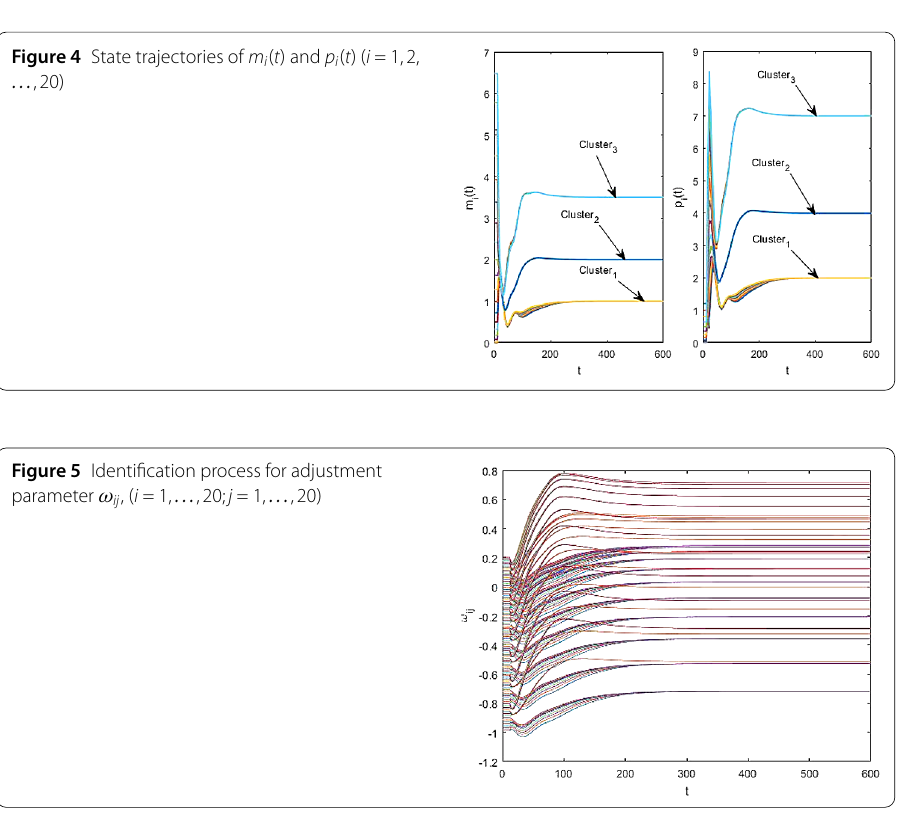
Figure 4 State trajectories of m i ( t ) and p i ( t ) ( i = 1,2, ... ,20)